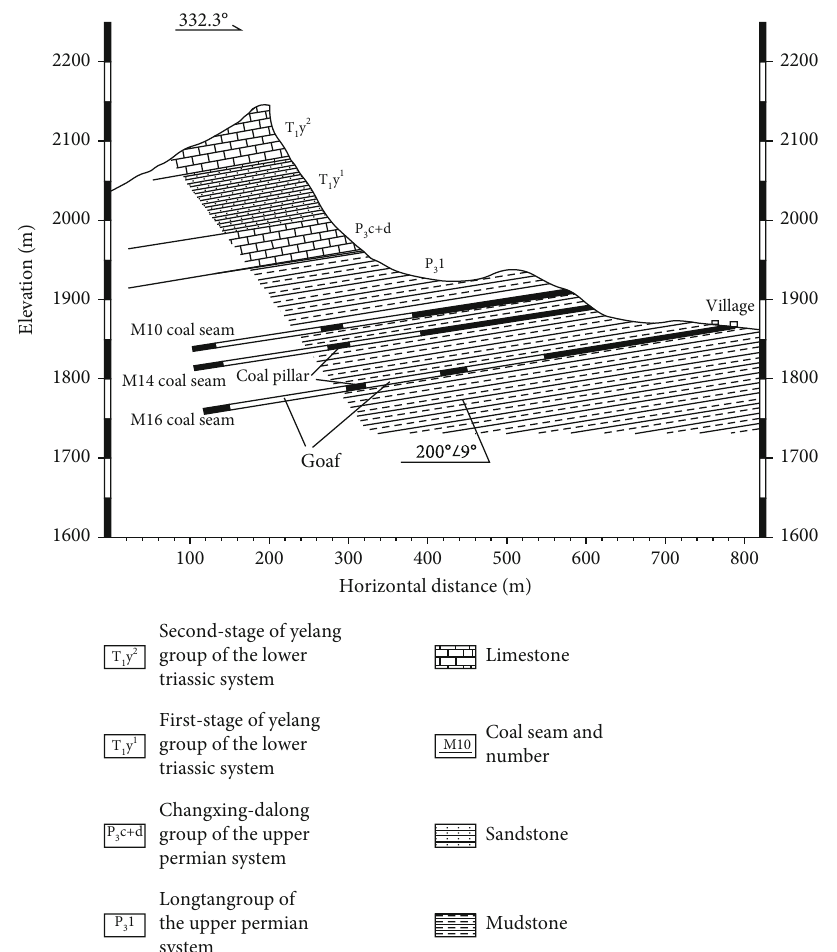
Figure 3: Typical cross-section of the slopes in the site (Pro fi le I-I ′ as shown in Figure